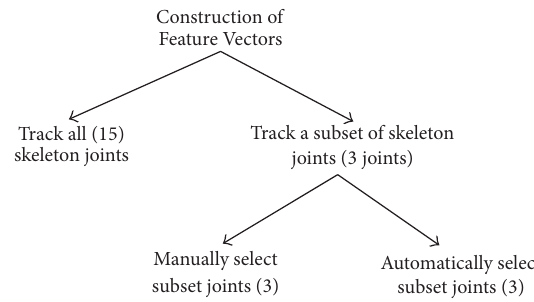
Figure 2: Methods developed for selecting feature vectors.